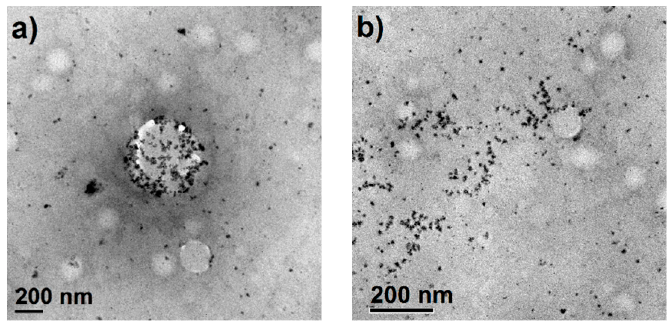
Figure 5. Transmission electron microscopy (TEM) ( a ) and ( b ) (larger surface area) images of AuNPs formed during the A 3 synthesis of 5a in the presence of 0.1 mol% of (dppta)AuCl 2 –SiO 2 @IL(PF 6 ) under solvent-free conditions.